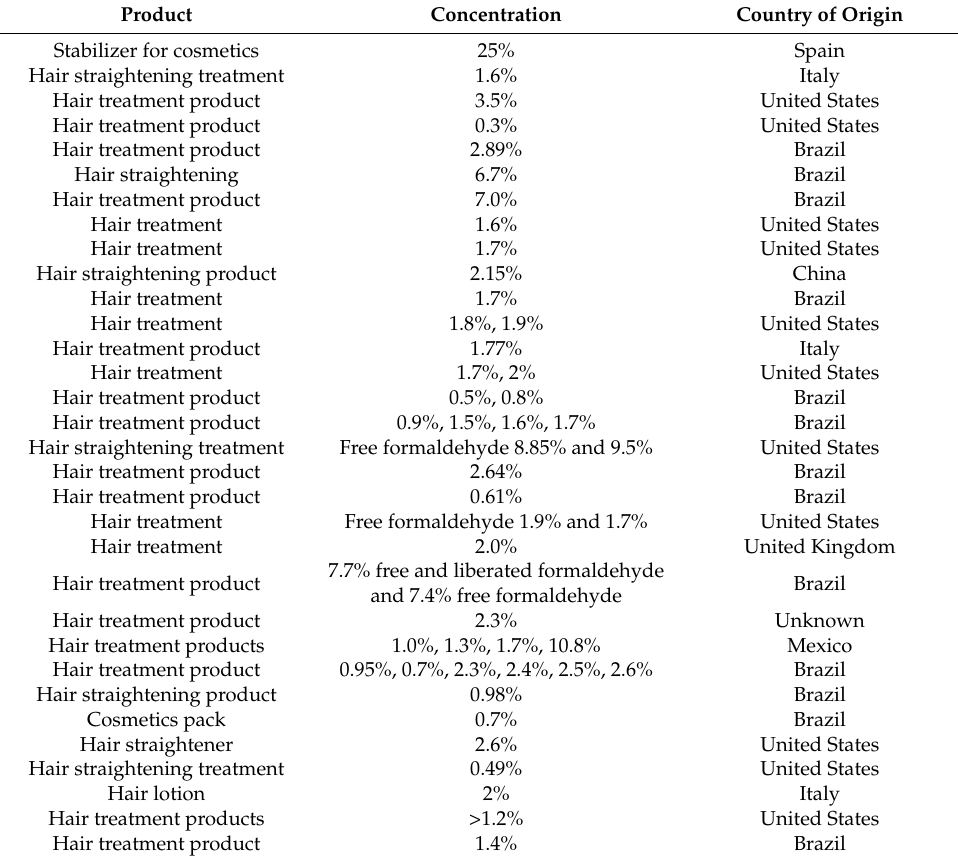
Table 3. Cosmetic products with high concentration of